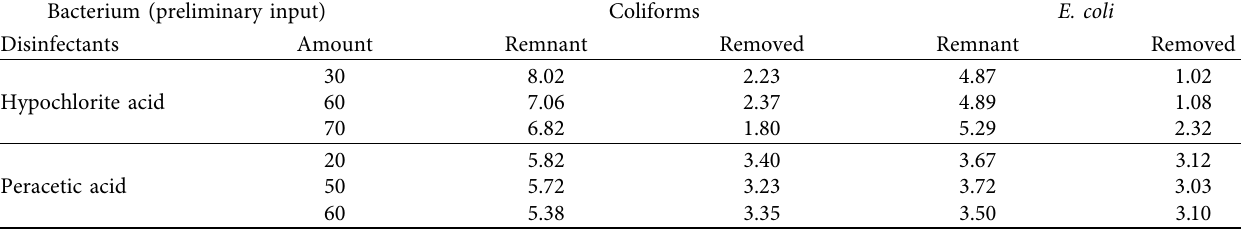
Table 3: Residual status and removal of E. coli and Coliforms after washing edible plants in disinfectants. Bacterium (preliminary input)